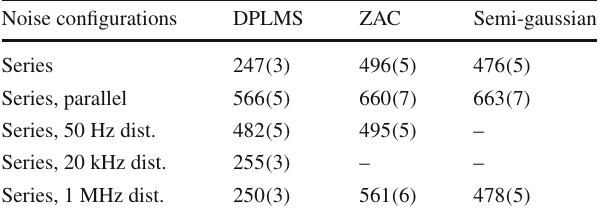
Table 1 The performance of the three filters (relative energy resolution FWHM in ppm) Noise configurations